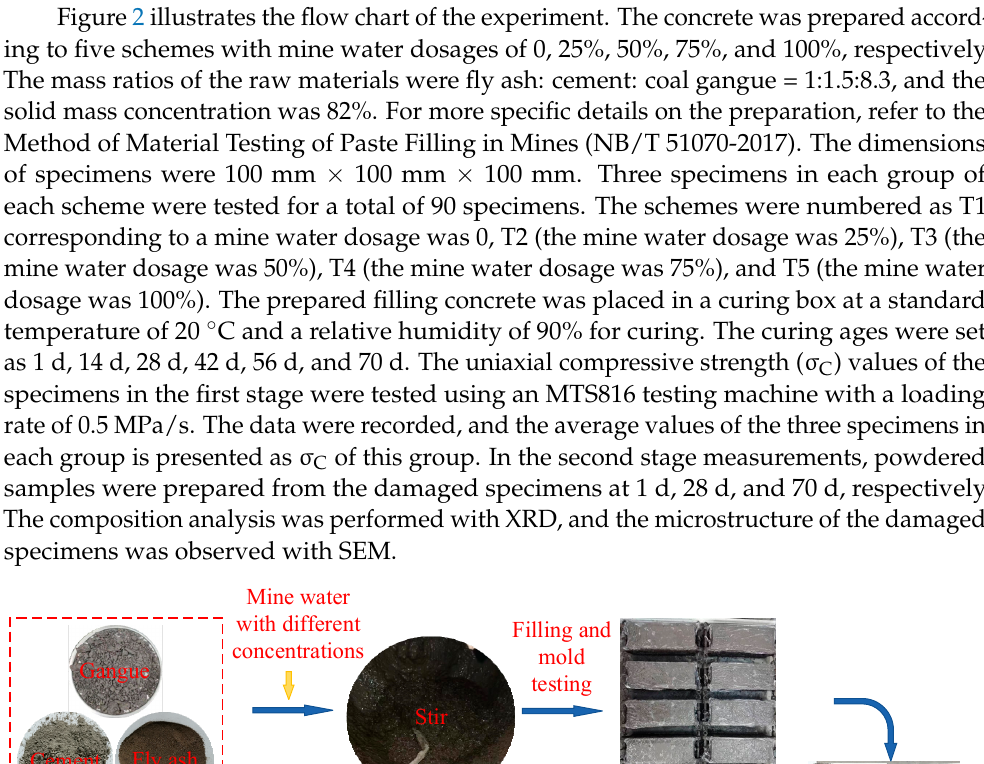
Table 3. Compressive strength of the filling concrete at different curing ages. Curing Age /d